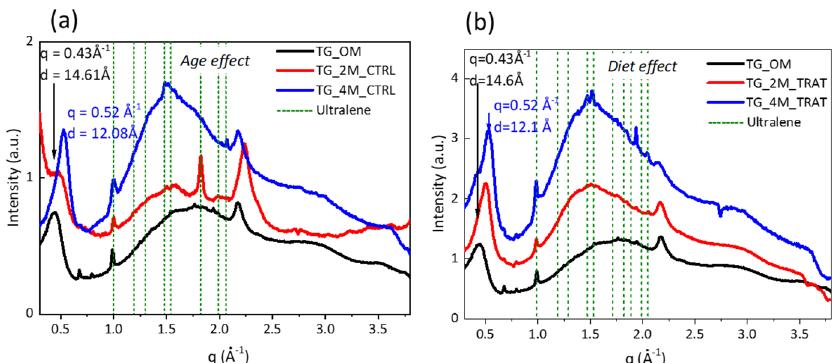
Figure 3. One-dimensional WAXS diffraction profiles obtained from radial integration of the signal selecting the q range of the equatorial signal (red dotted panel) of Tilapia skin. The comparison is shown between 1D profiles of fish fed with conventional feed ( a ) at time point 0 (TG_0, black profile) and after two and four months of diet (TG_2M_CTRL, red profile and TG_4M_CTRL, blue profile) and fish fed with conventional feed ( b ) at time point 0 (T0, black profile) and fish fed with a collage-rich diet for two and four months (TG_2M_TRAT, red profile and TG_4_M_TRAT, blue profile).